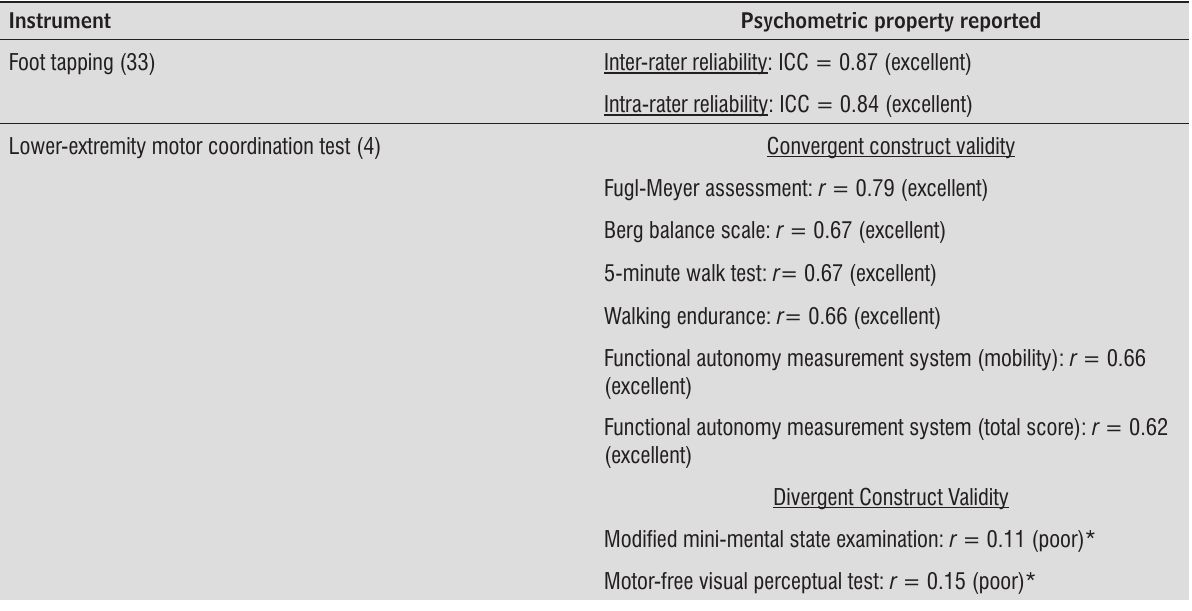
Table 2 - Values of the psychometric properties of the specific tests for the evaluation of lower limb motor coordination, re- ported by the studies included in the review